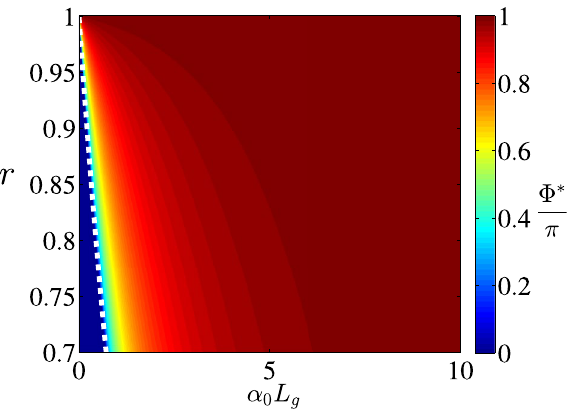
Figure 4. Non-trivial steady-state solution (cid:31) ∗ of Eq. (12) vs. parameters r and α 0 L g . White dashed line shows the boundary between domains Eqs. (16) and (17), i.e. to the left of this boundary non-trivial solution (cid:31) ∗ does not exist. This figure was created with Matlab R2018a (http://www.mathw